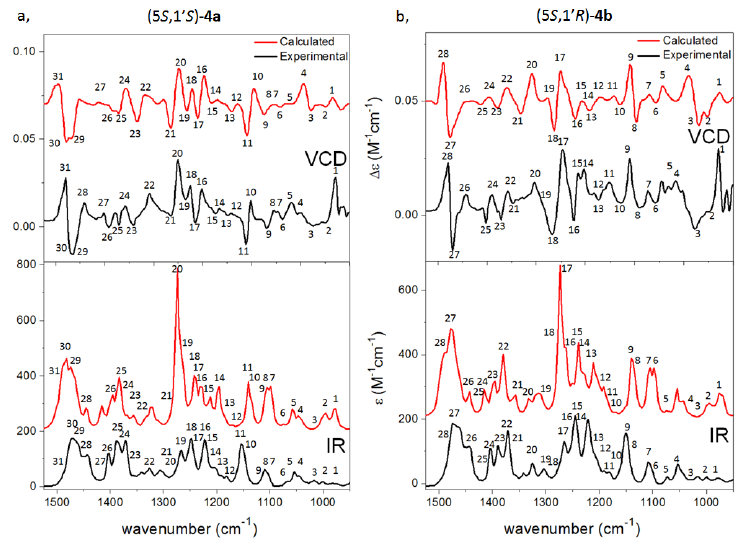
Figure 5. Experimental VCD (upper black) and IR spectra (lower black) of ( a ) (5 S ,1 ′ S ) ‐ 4a and ( b ) (5 S ,1 ′ R ) ‐ 4b compared with the B3LYP/TZPV PCM/CHCl 3 VCD (upper red) and IR (lower red) spectra.